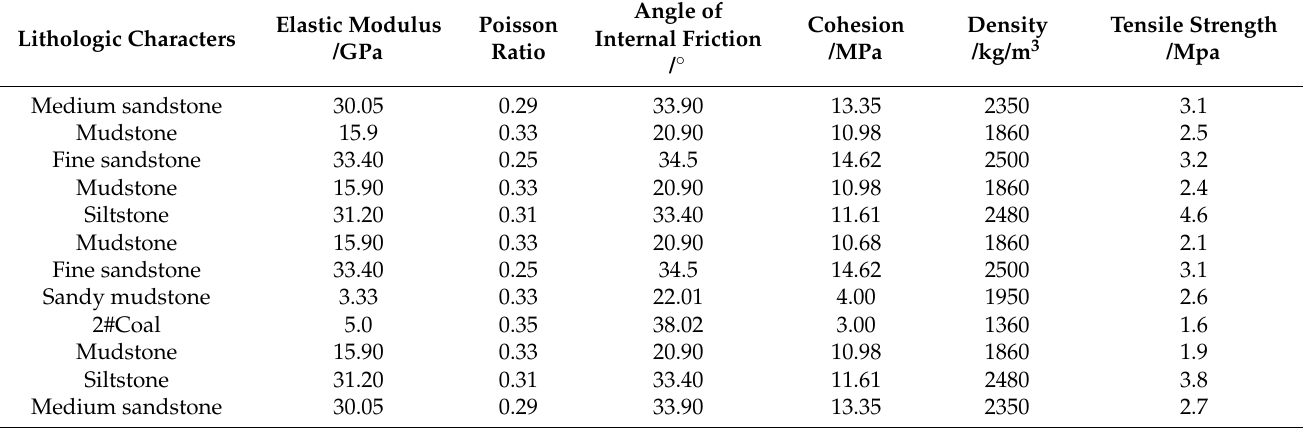
Table 2. Rock macro physical and mechanical